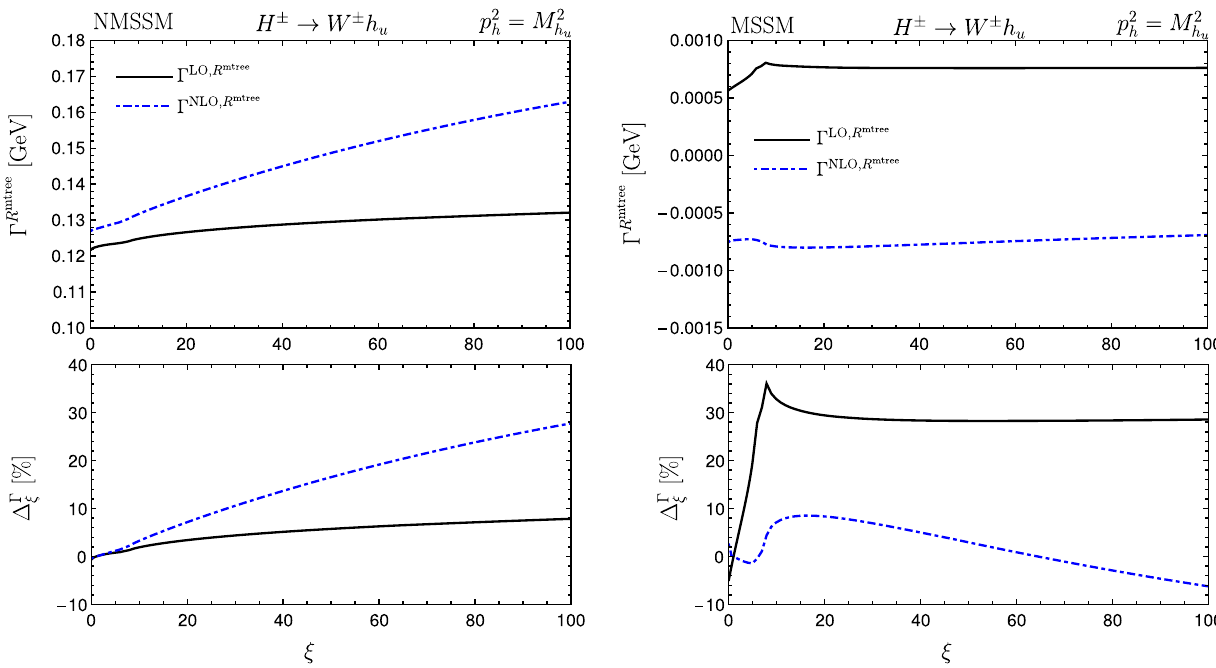
Fig. 12 Same as Fig. 10, but using the R mtree -method instead of the iterative approach to extract the loop-corrected masses and mixing